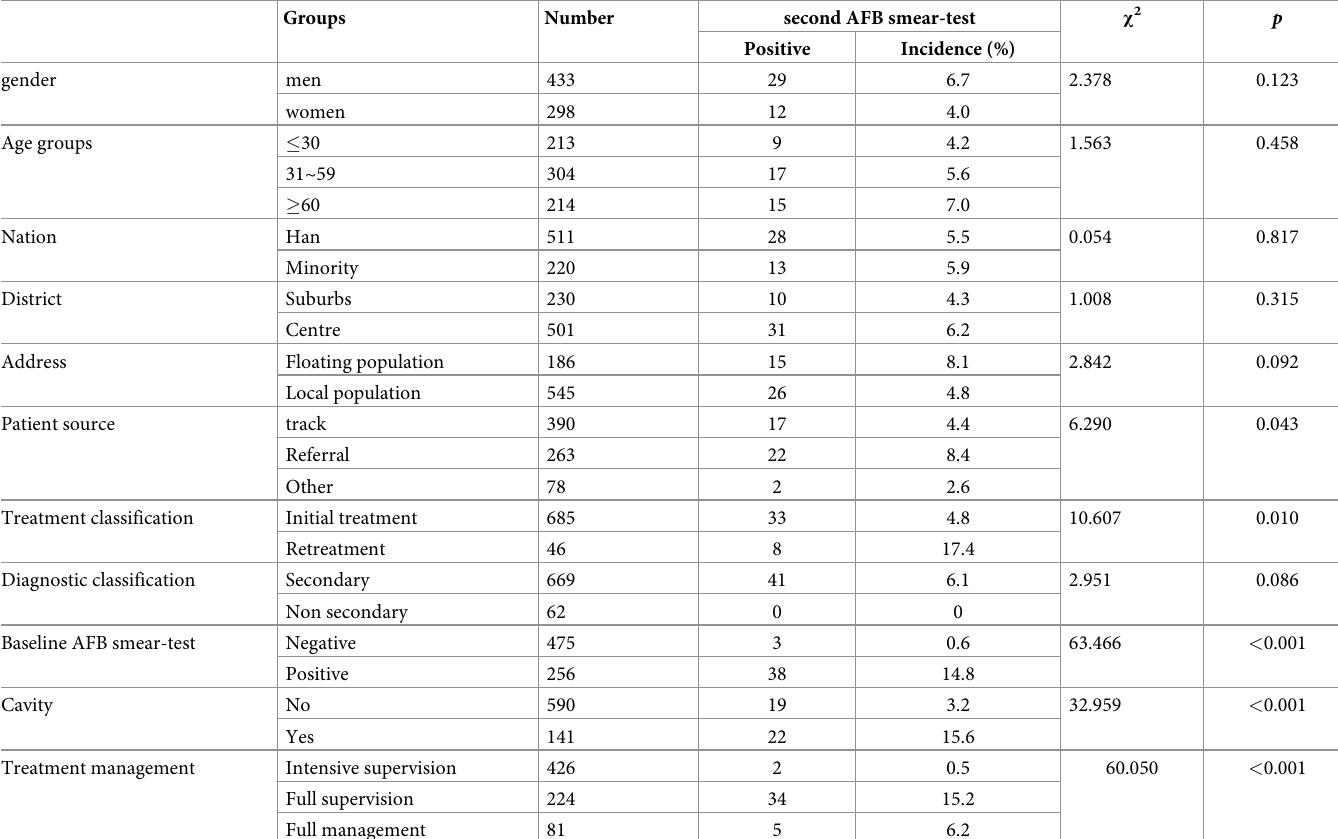
Table 1. Comparison of second AFB smear-positive status among different TB patients.